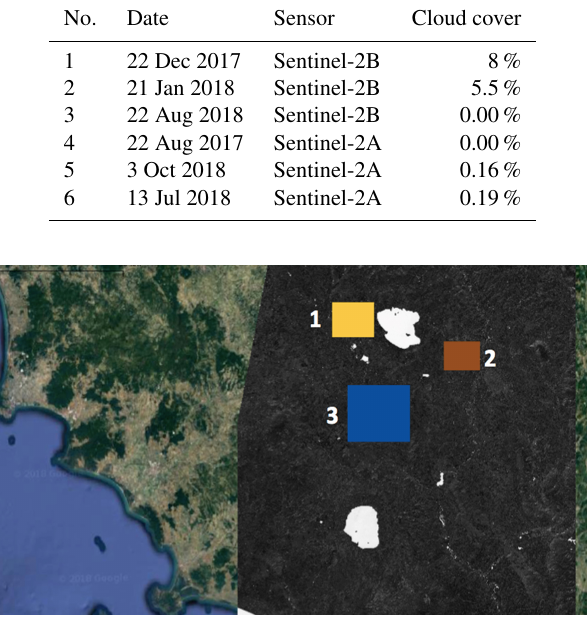
Figure 7. Test areas (T1, T2, T3) selected for the NDWI–MNDWI comparison. ©Google Map source: Immagini©2018 TerraMetrics, Dati